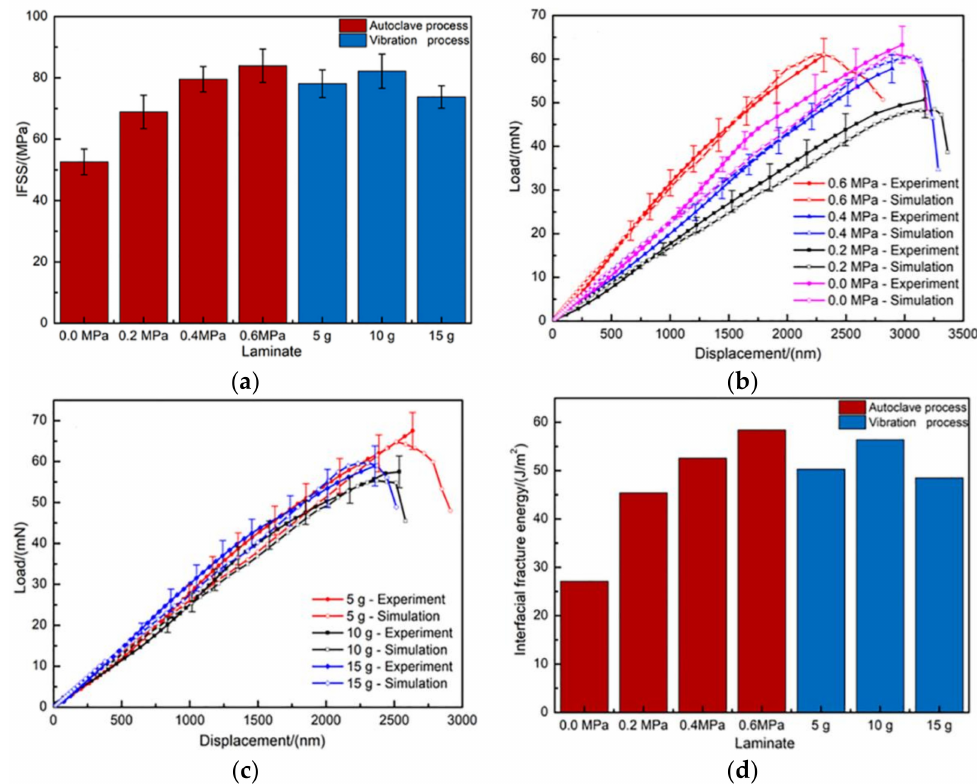
Figure 5. ( a ) IFSS of composites produced by different curing cycles, ( b ) experimental and numerical load-displacement curves of push-out tests for composites produced by the autoclave process, ( c ) experimental and numerical load-displacement curves of push-out tests for composites produced by RVAVP, ( d ) interface fracture toughness of composites produced by different curing